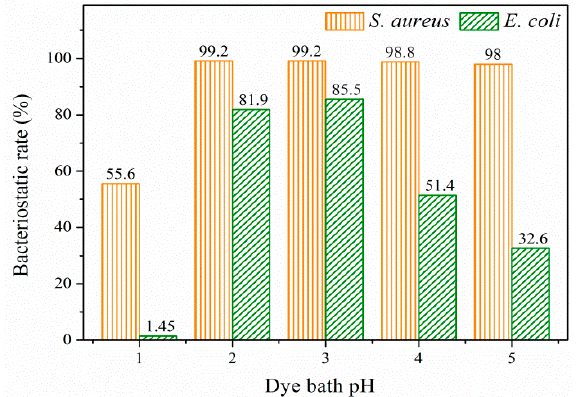
Figure 11. Bacteriostatic rates of cotton fabrics dyed under different pH values.